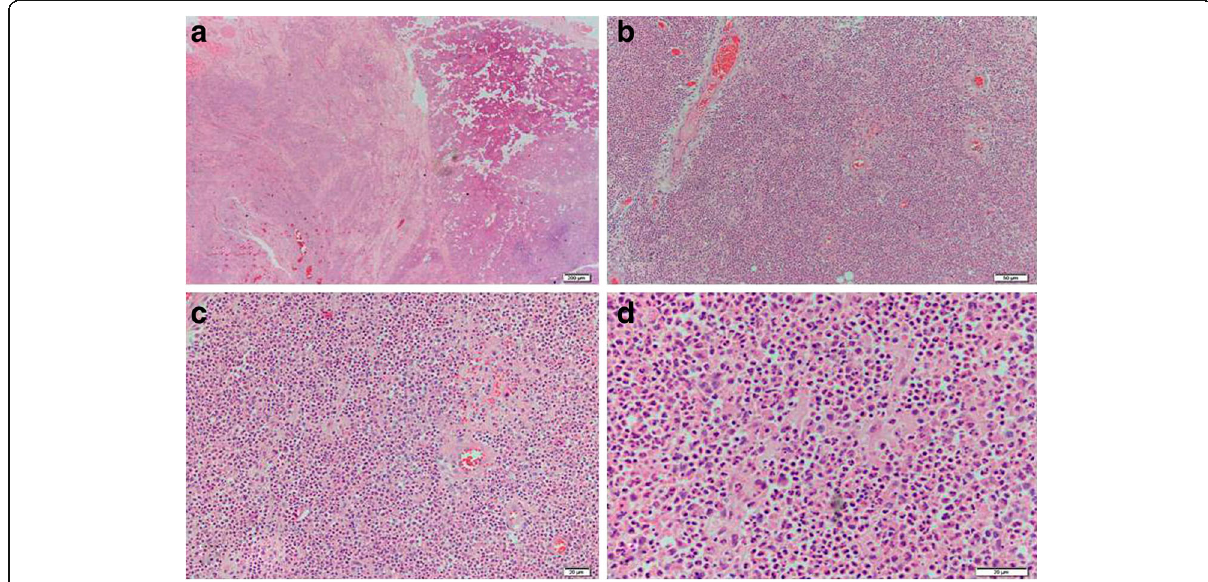
Fig. 1 Histopathologic evaluation of parotid tissue specimens from the patient. Suppurative inflammation is observed in the parotid ( a , b , c and d ). Hematoxylin and eosin stain, original magnification: ( a ) 20×, ( b ) 100×, ( c ) 200× and ( d ) 400×. Scale bars indicate ( a ) 200 μ m, ( b ) 50 μ m, or ( c and d ) 20 μ